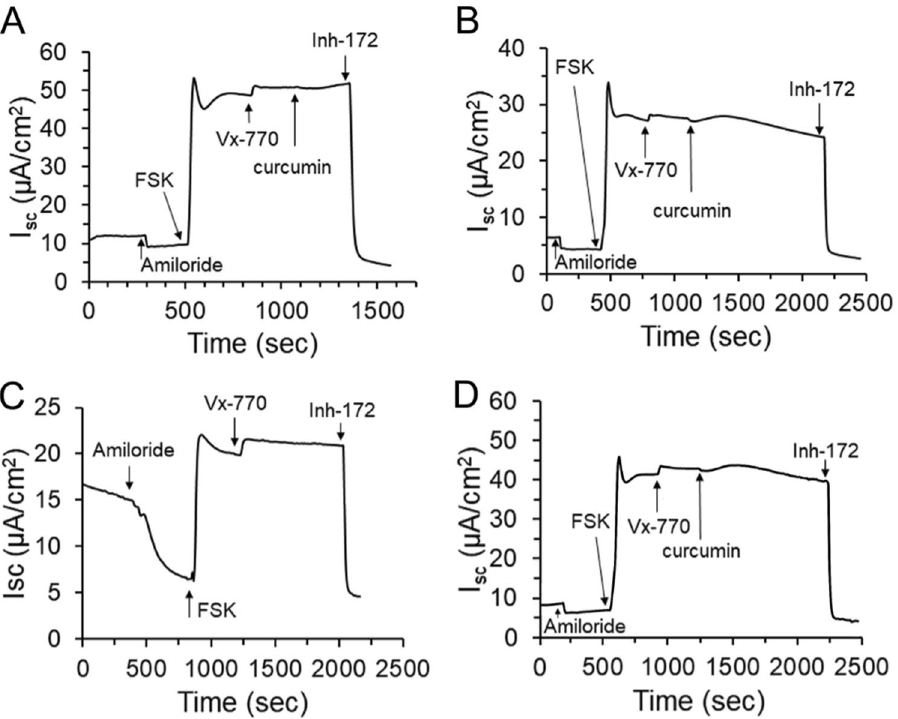
Figure 6. Representative electrophysiological analysis of primary tracheal and nasal airway epithelia expanded using CRC conditions and differentiated in E-ALI. ( A , B ) P0 NhTEC cultured in E-ALI for 16 weeks ( A ) or 21 weeks ( B ) show comparable response profiles to the ENaC inhibitor amiloride and agents that stimulate or inhibit CFTR currents. ( C , D ) NhNE cells that were expanded using CRC conditions to P4 and then differentiated with E-ALI for 2 weeks ( C ) or 7 weeks ( D ), also exhibited comparable ENaC and CFTR current profiles. FSK, Forskolin; Vx-770, Ivacaftor; CFTRinh172, CFTR channel